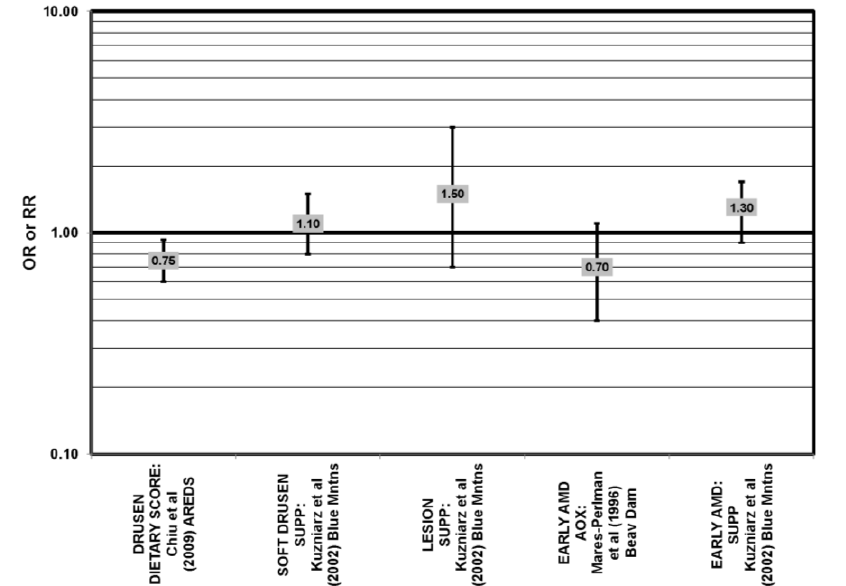
Figure 35. Odds or risk ratio for early AMD indicators (SOFT DRUSEN, LESION) or early AMD; high vs. low antioxidant index (AOX) intake or use of multivitamin supplements: retrospective and cross-sectional